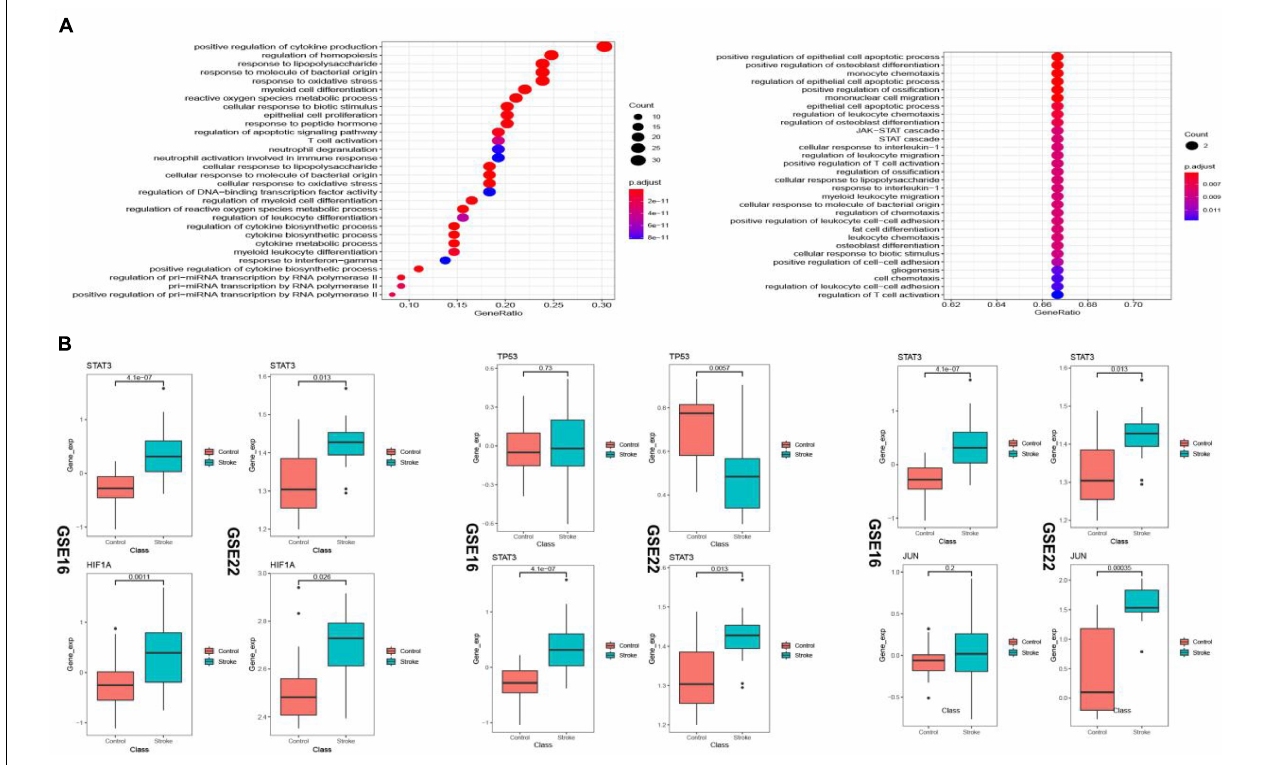
FIGURE 11 | Biological pathways (BP) enriched in the up- and down-regulated transcriptional regulatory immunosuppression-related crosstalk genes (A) . Expression levels of key transcription factors and corresponding target crosstalk genes in the stroke and control samples in the two datasets (B)